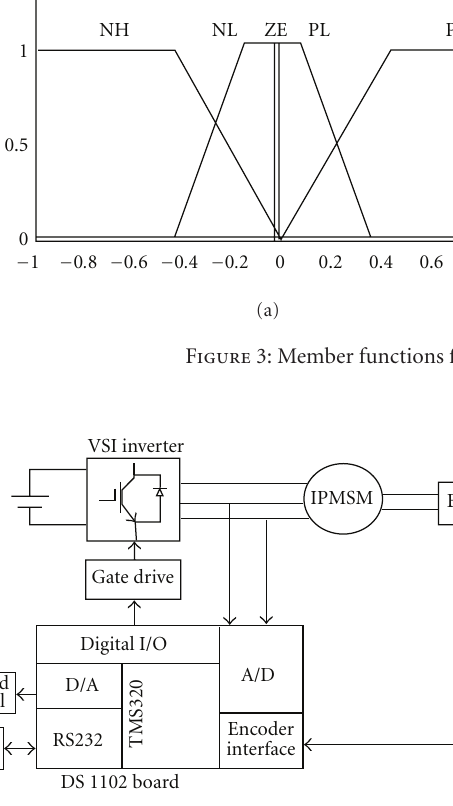
Figure 4: Hardware schematic for real-time implementation.